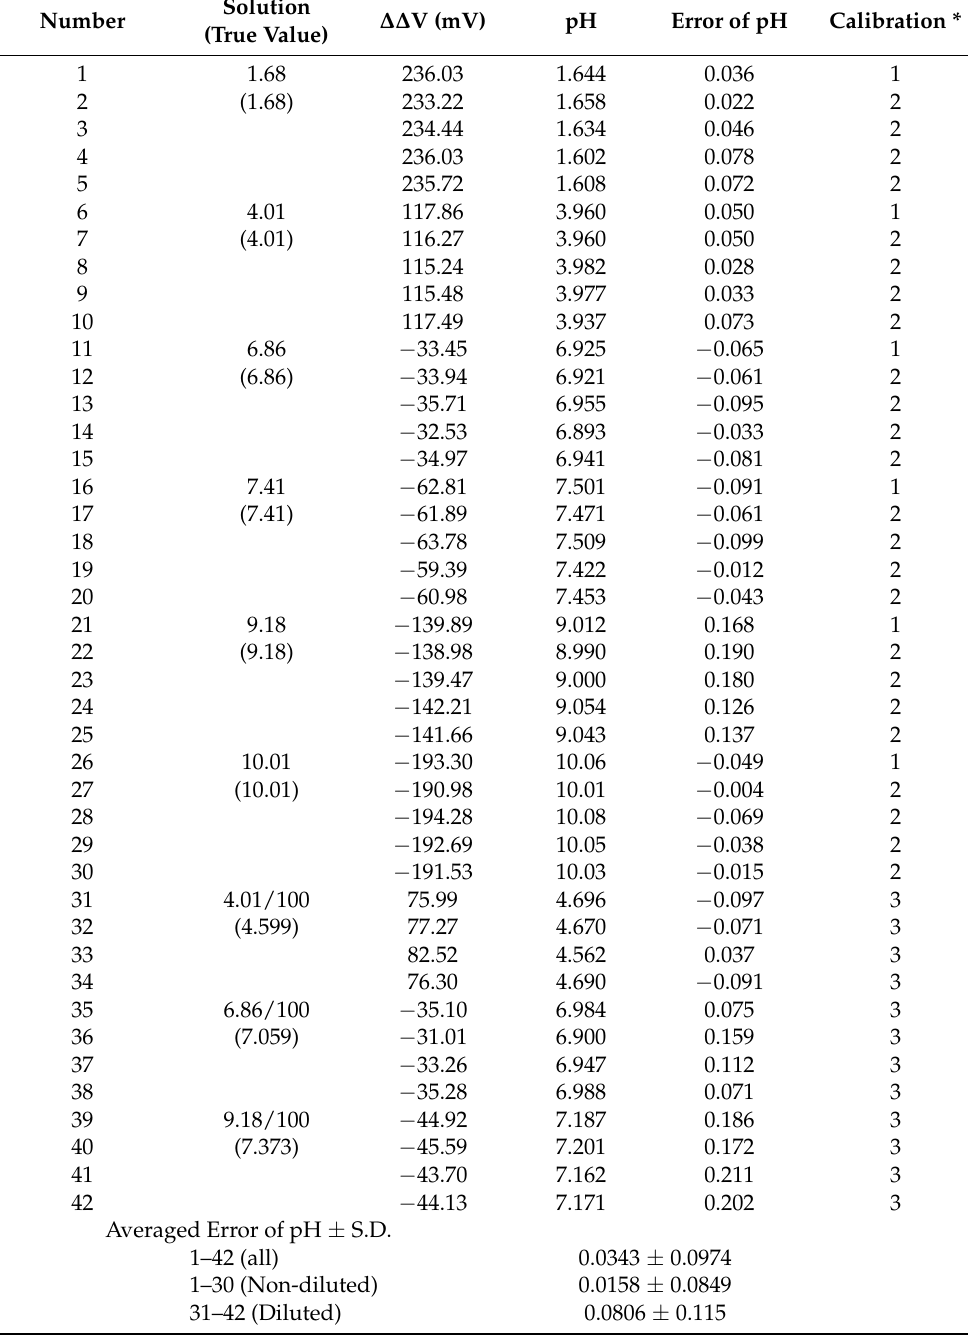
Table 1. pH measurement error using the present